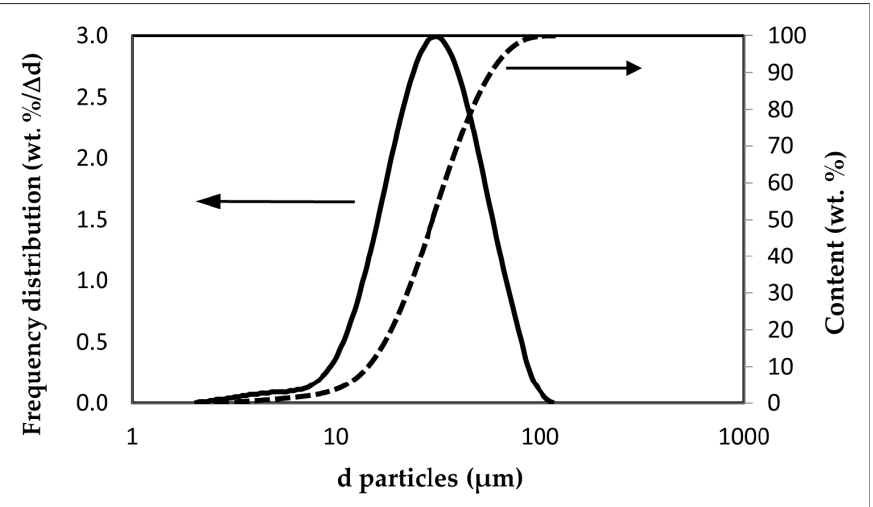
Figure 5. Particle size distribution (LD) of a plasma-treated W-5Ni-2Fe micropowder after nano- particles has been removed.